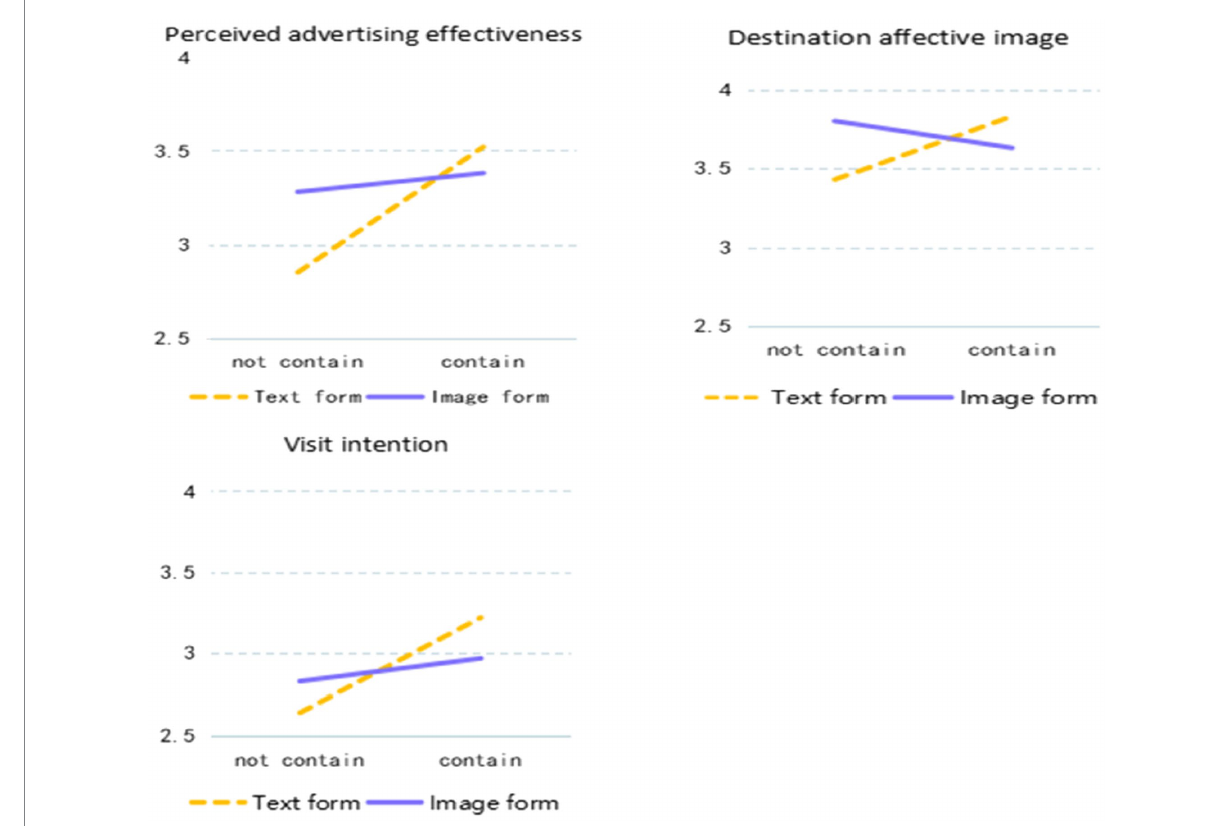
FIGURE 4 Mean value for perceived advertising effectiveness, destination affective image, and visit intention. Source: Made by the